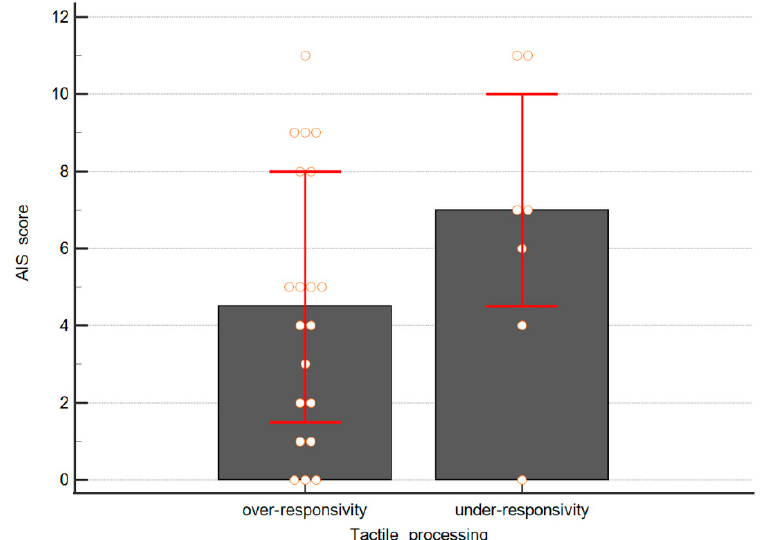
Figure 2. Athens Insomnia Scale (AIS) score by means of tactile processing disorders. Boxes represent medians and bars represent interquartile ranges ( p = 0.51).